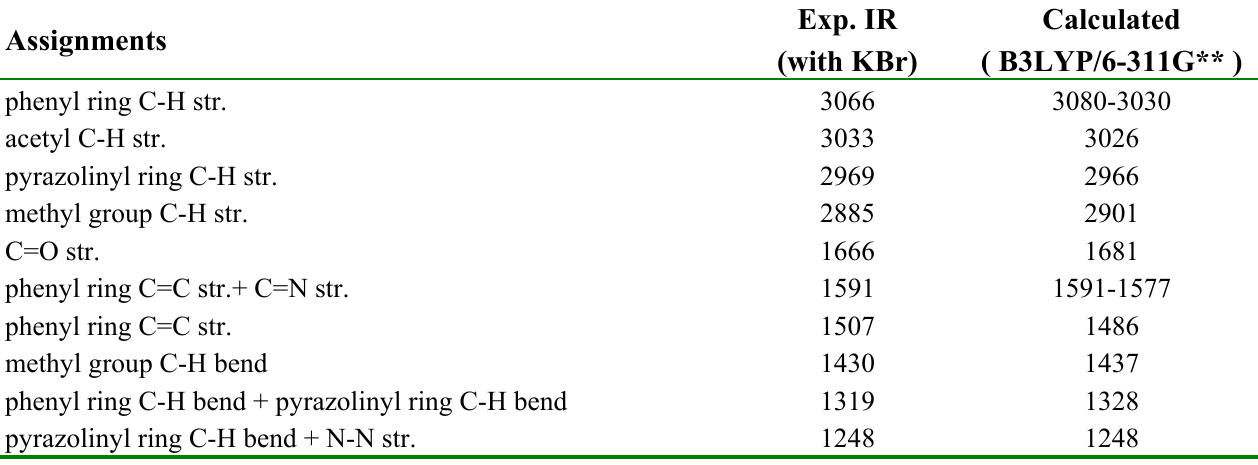
Table 2. Comparison of the observed and calculated vibrational spectra of the title compound .